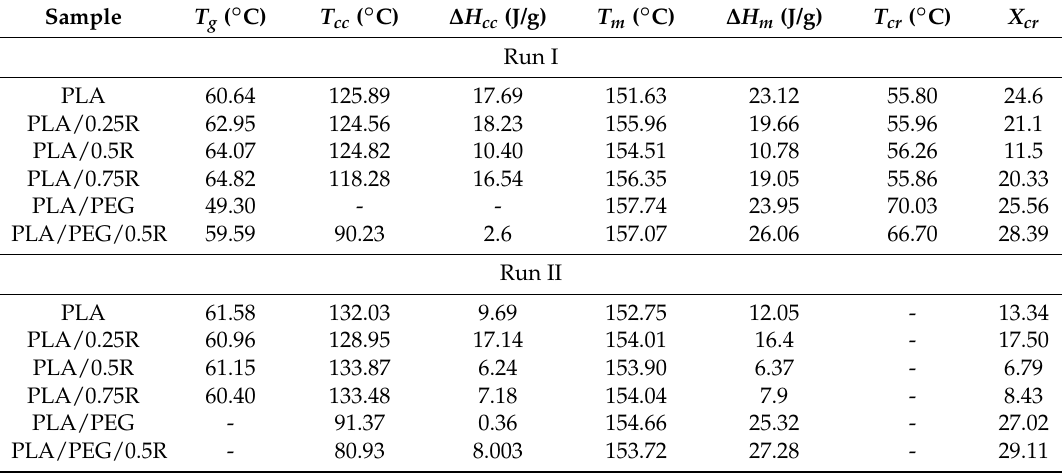
Table 5. Thermal characteristics of the PLA/R and plasticized PLA/R systems determined